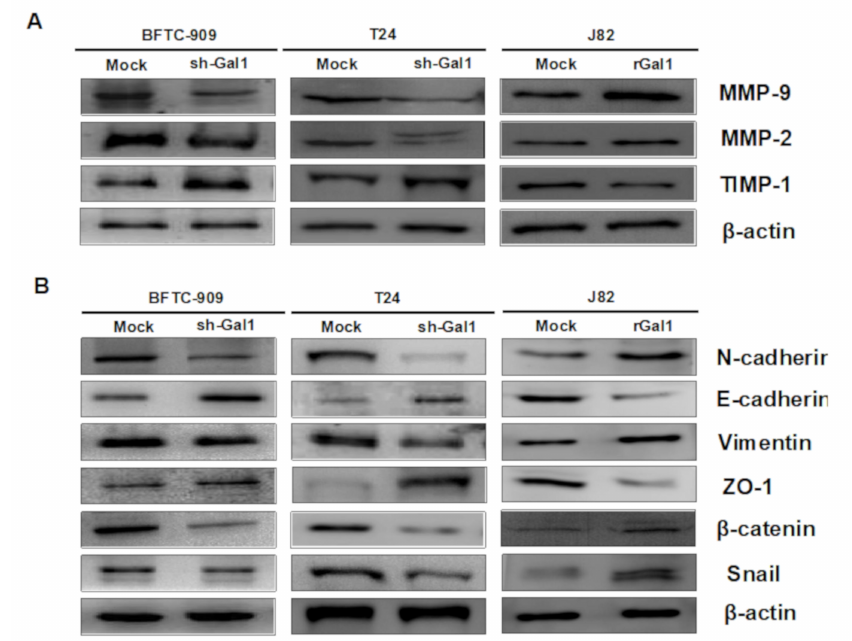
Figure 5. E ff ect of GAL1 on MMPs and EMT pathway proteins assessed through Western blotting analysis. Mock: cells treated with DMSO vehicle only. β -Actin was used as the protein loading control. ( A ) Total cell lysates of the BFTC-909, T24, and J82 cells treated with shRNA or GAL1 recombinant protein (1 µ g / mL) were analyzed in terms of expression levels of MMP-2, MMP-9, and TIMP-1 by Western blotting. ( B ) Total cell lysates of the BFTC-909, T24, and J82 cells treated with shRNA or GAL1 recombinant proteins (1 µ g / mL) were analyzed in terms of expression levels of EMT pathway through Western blotting